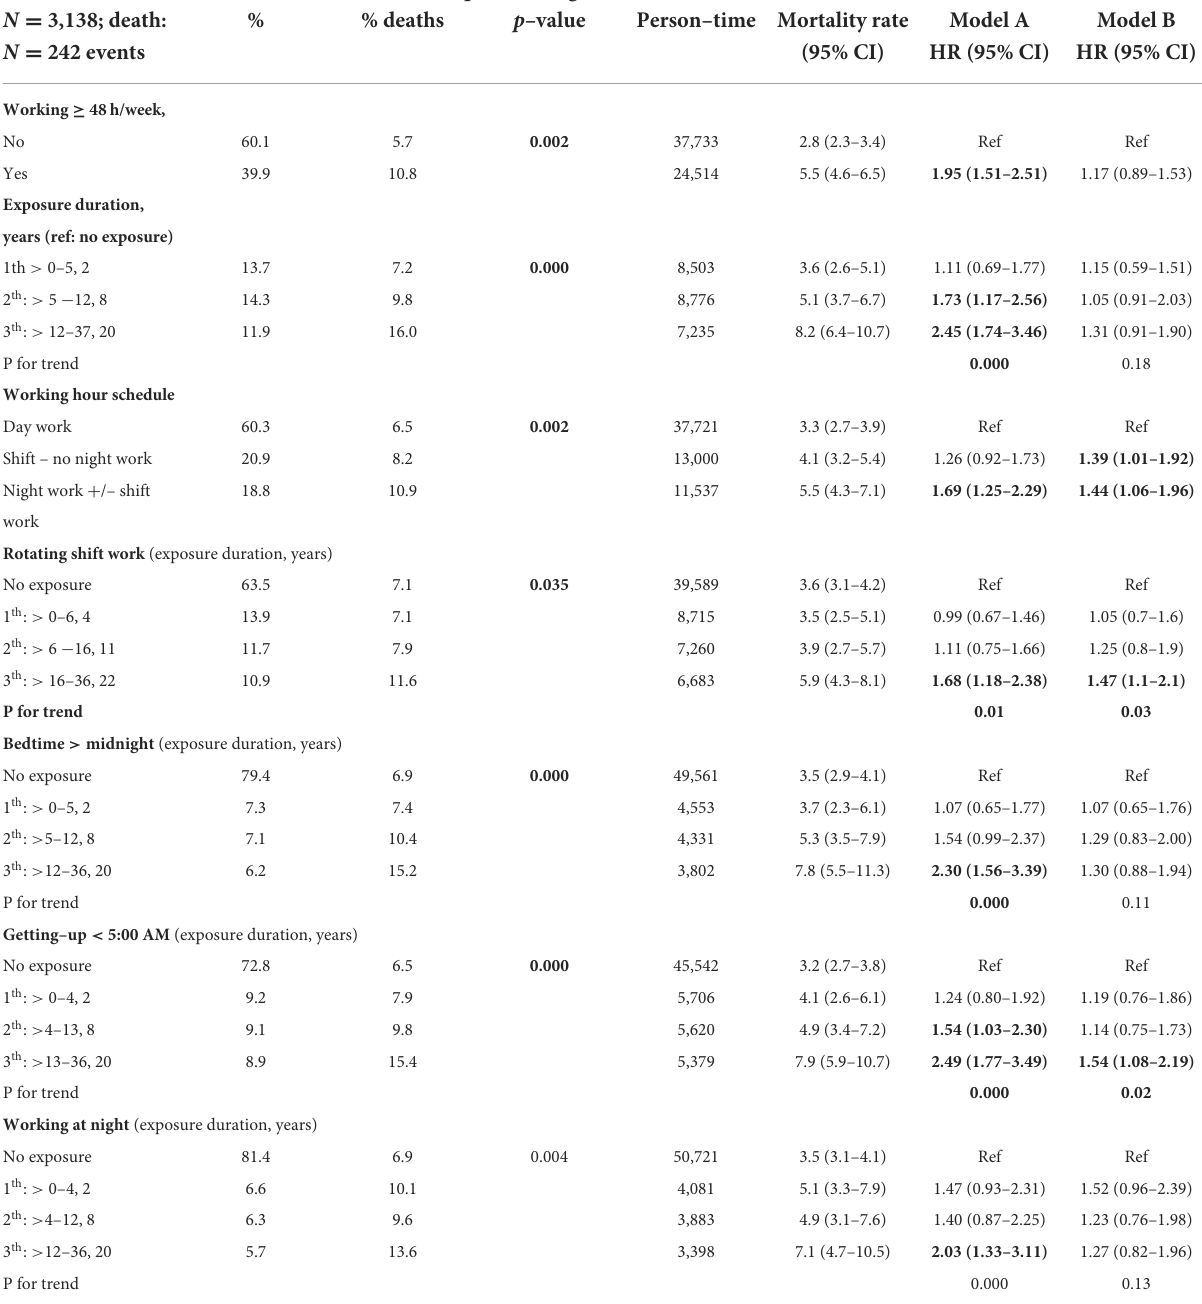
TABLE 2 Occupational organizational constraints and all-cause mortality. Occupational organizational